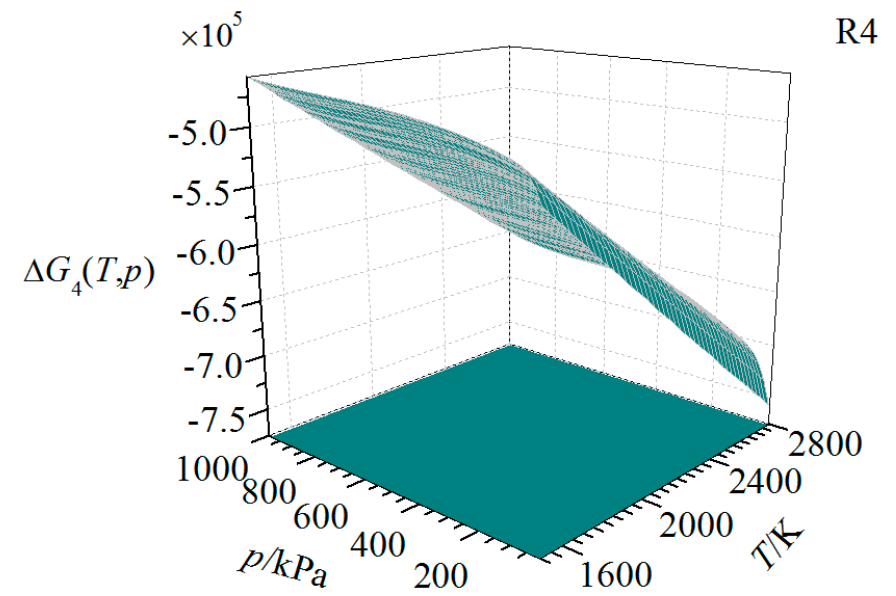
Figure 9. Gibbs energy dependence on temperature and CO partial pressure for reaction R4.